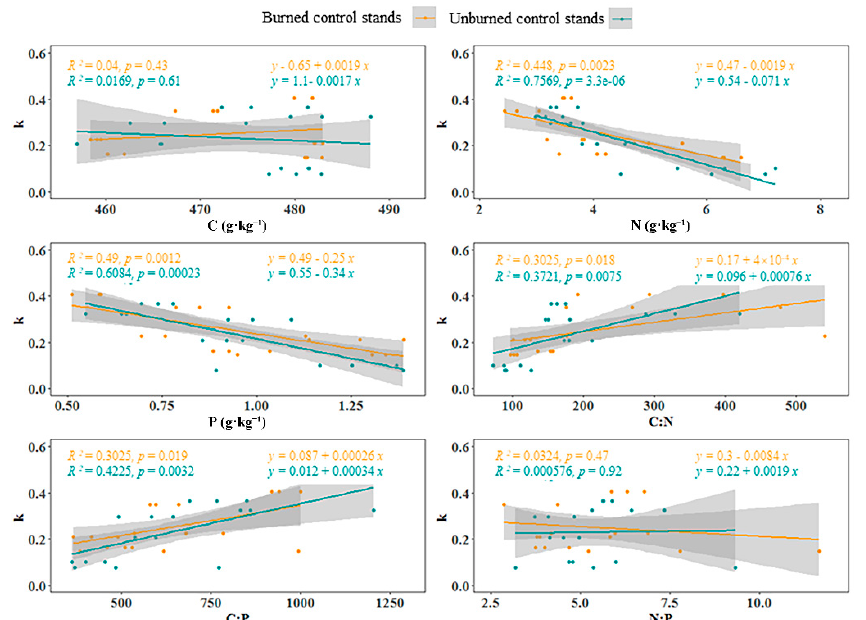
Figure 5. Linear relationships between C, N, P, and their ratios and the litter decomposition rate ( k ) ( n = 3). Note: The grey area is the 95% confidence interval.